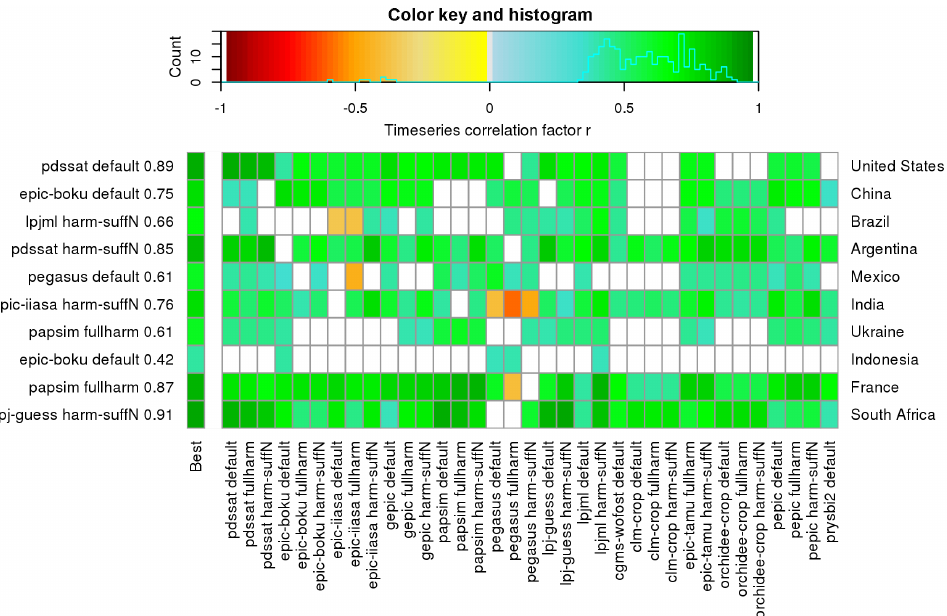
Figure 6. Time series correlation coefficients for the top-10 maize producing countries. Rows display the individual countries ordered by production; left-hand labels describe the best performing GGCMs for that country and the correlation coefficients. White boxes indicate that correlations are not statistically significant. Each column displays individual GGCM × harmonization combinations, omitting all for which data are not available. The leftmost column displays the best correlation coefficient for each country (row), corresponding to the row labels on the left. Color legend key on top includes a histogram (cyan line) that shows the distribution of correlation coefficients across the ensemble and the top-10 producing countries, excluding the “best” column.